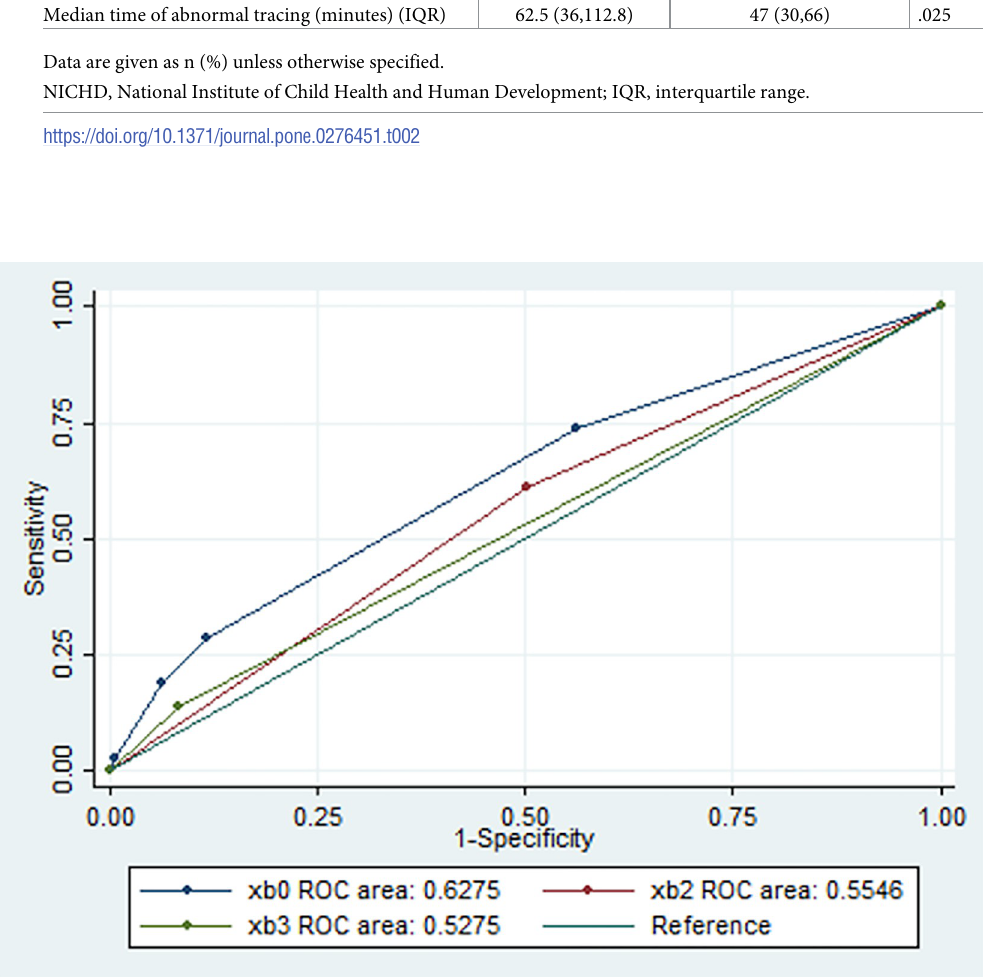
Fig 1. Receiver operating curves (ROC) demonstrating the comparison of predictive abilities among the NICHD 3-tier system combined with significant risk factors, the NICHD 3-tier system alone, and the Fetal Reserve Index. xb0, the NICHD 3-tier system combined with significant risk factors (preeclampsia, abnormal labor; arrest disorders of labor or abnormal second stage of labor, meconium-stained amniotic fluid); xb2, the NICHD 3-tier system alone; xb3, the Fetal Reserve Index. p value